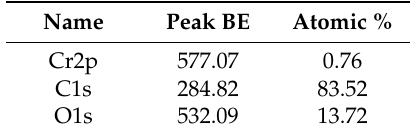
Figure 8. XPS spectra of the TFS surface. Table 1. The element content of the TFS surface.